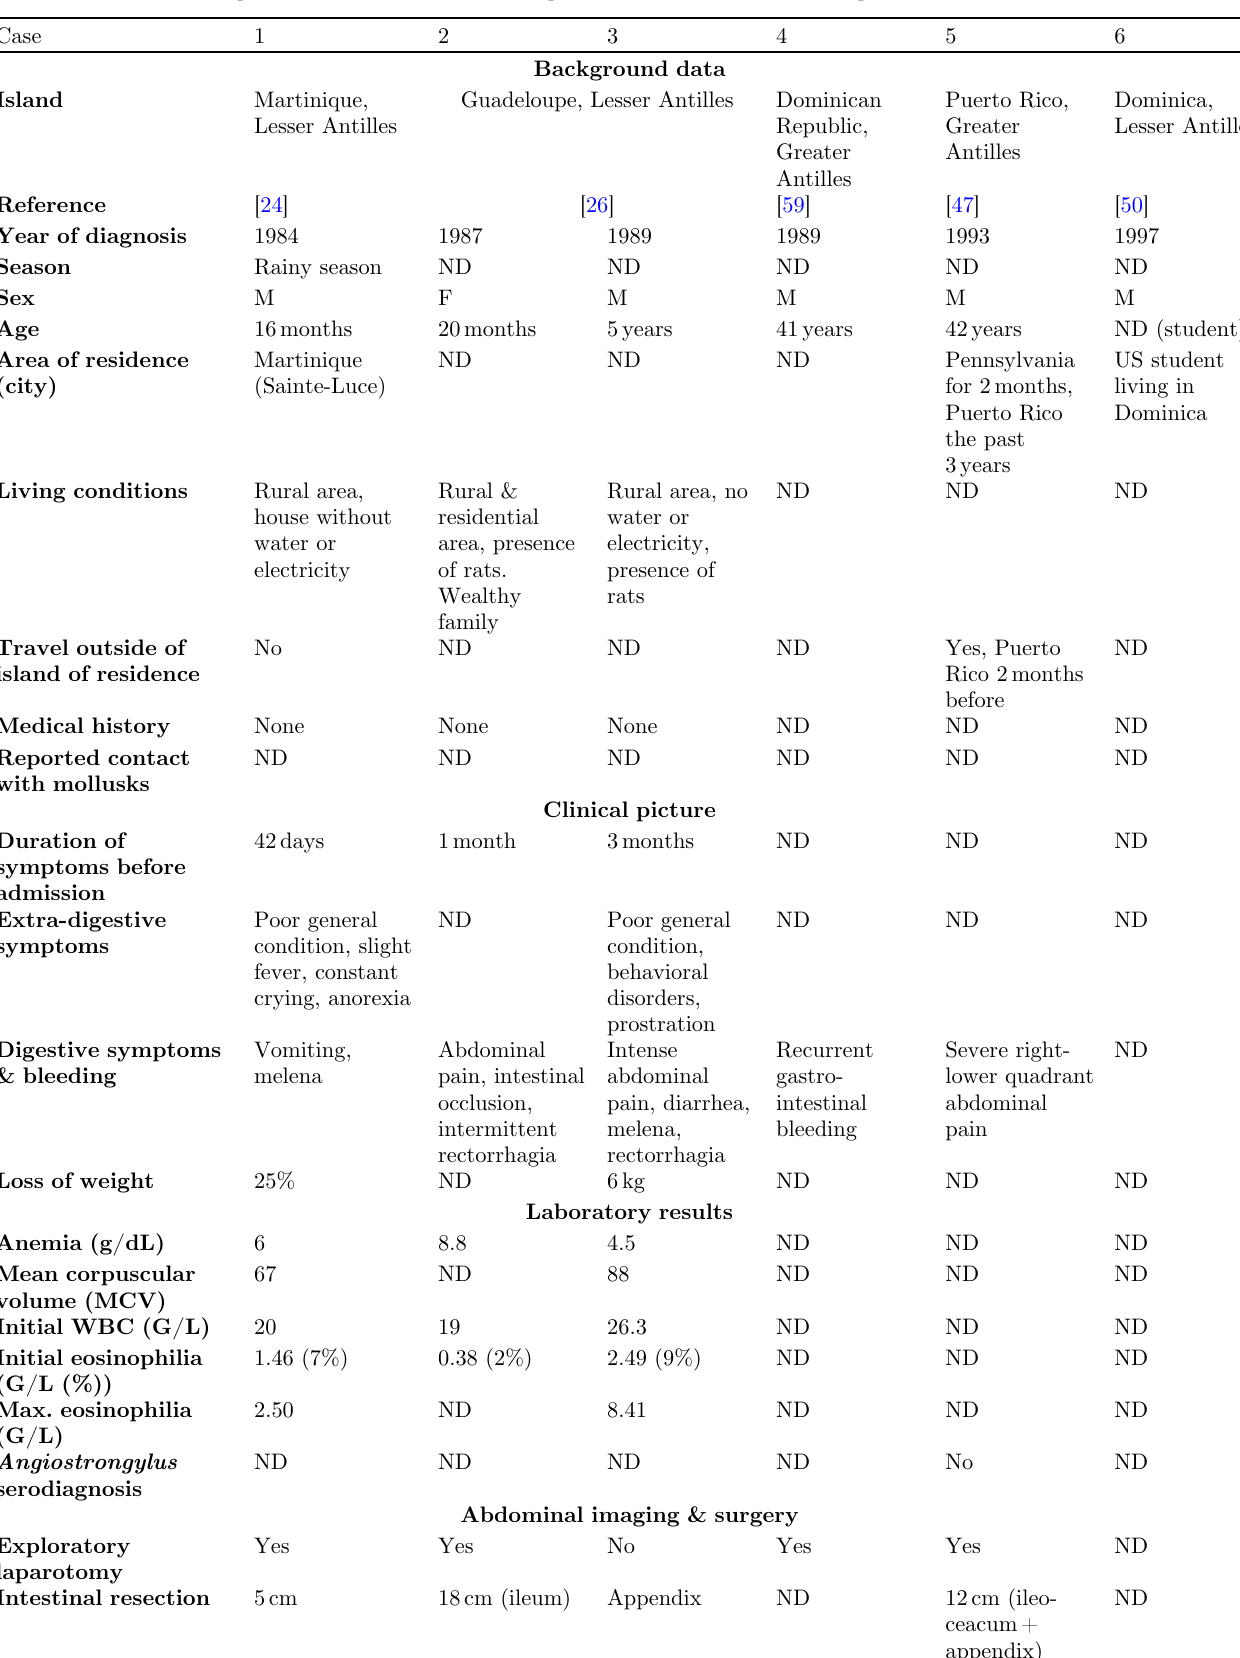
Table 2. Abdominal angiostrongyliasis in the Antilles. Literature review of the six HAA cases described in the Greater and Lesser Antilles before the description of the new con fi rmed and probable HAA cases in Martinique. ND: No Data.